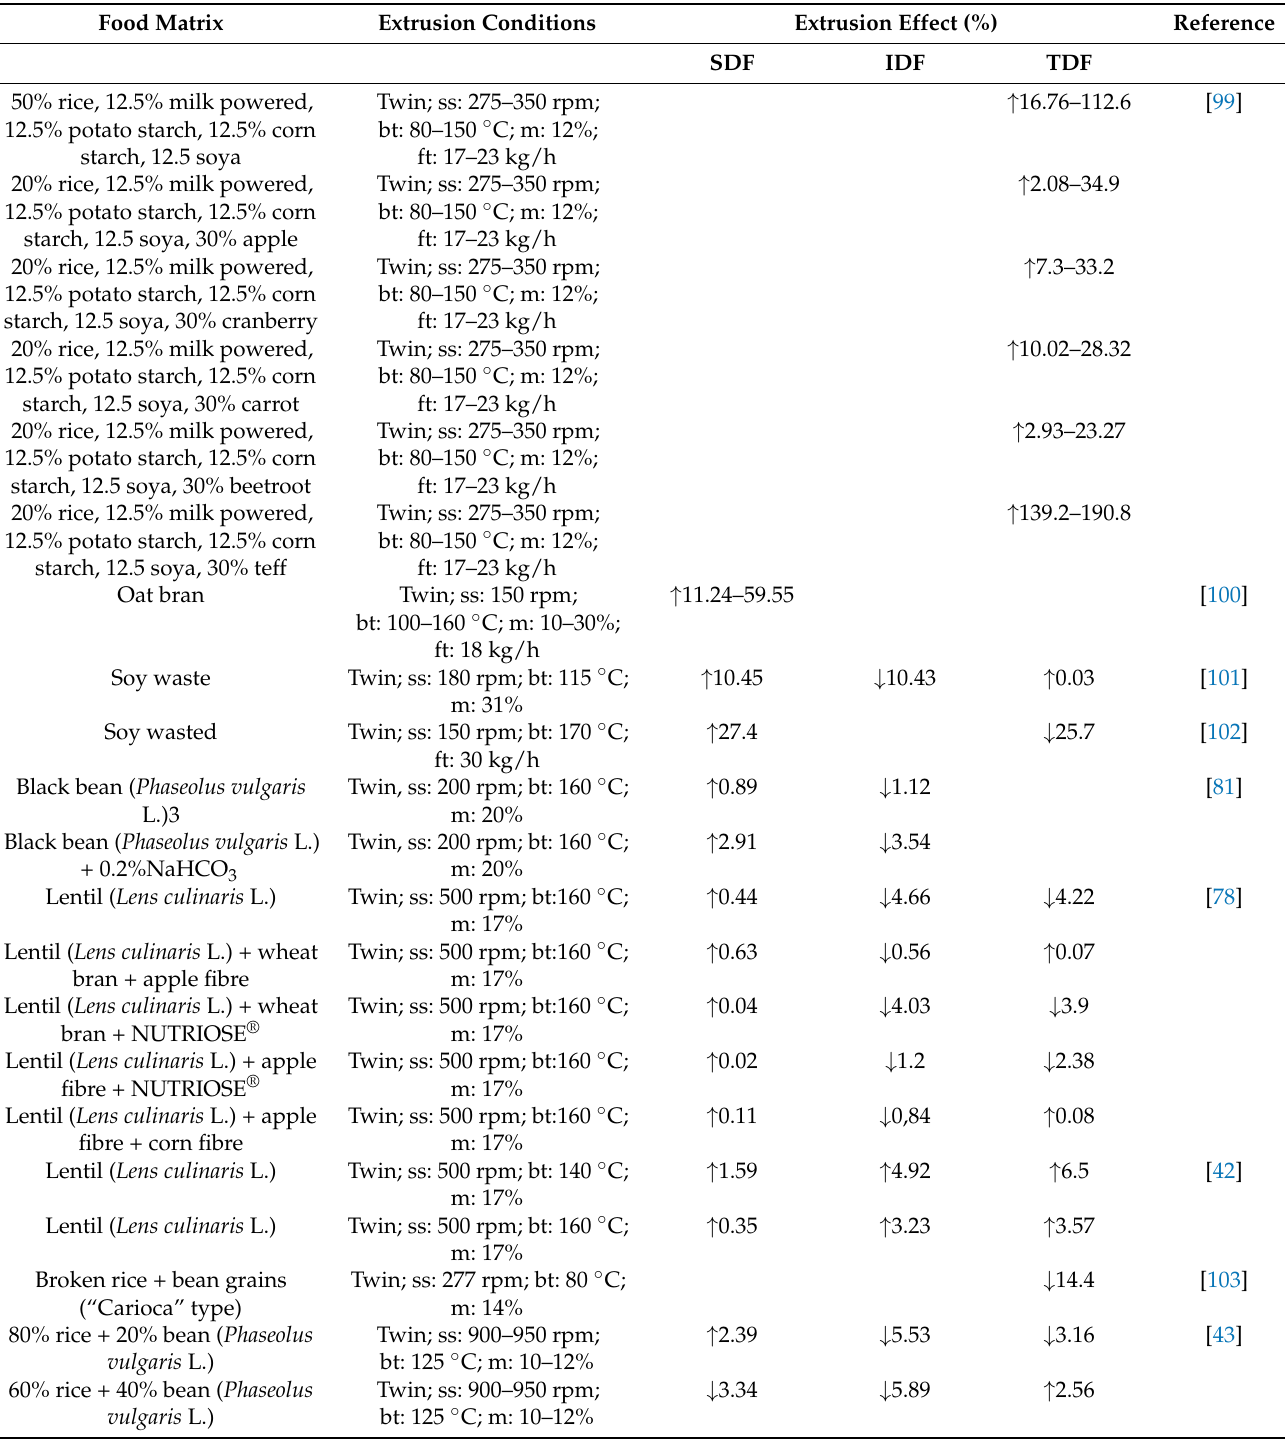
Table 3. Extrusion processing conditions effect on the dietary fibre content (soluble, insoluble and total) content of extruded